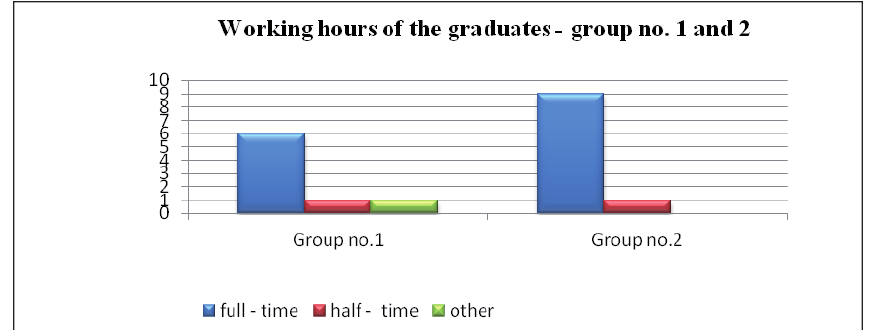
Fig. 2. Working hours of graduates from group 1 and group